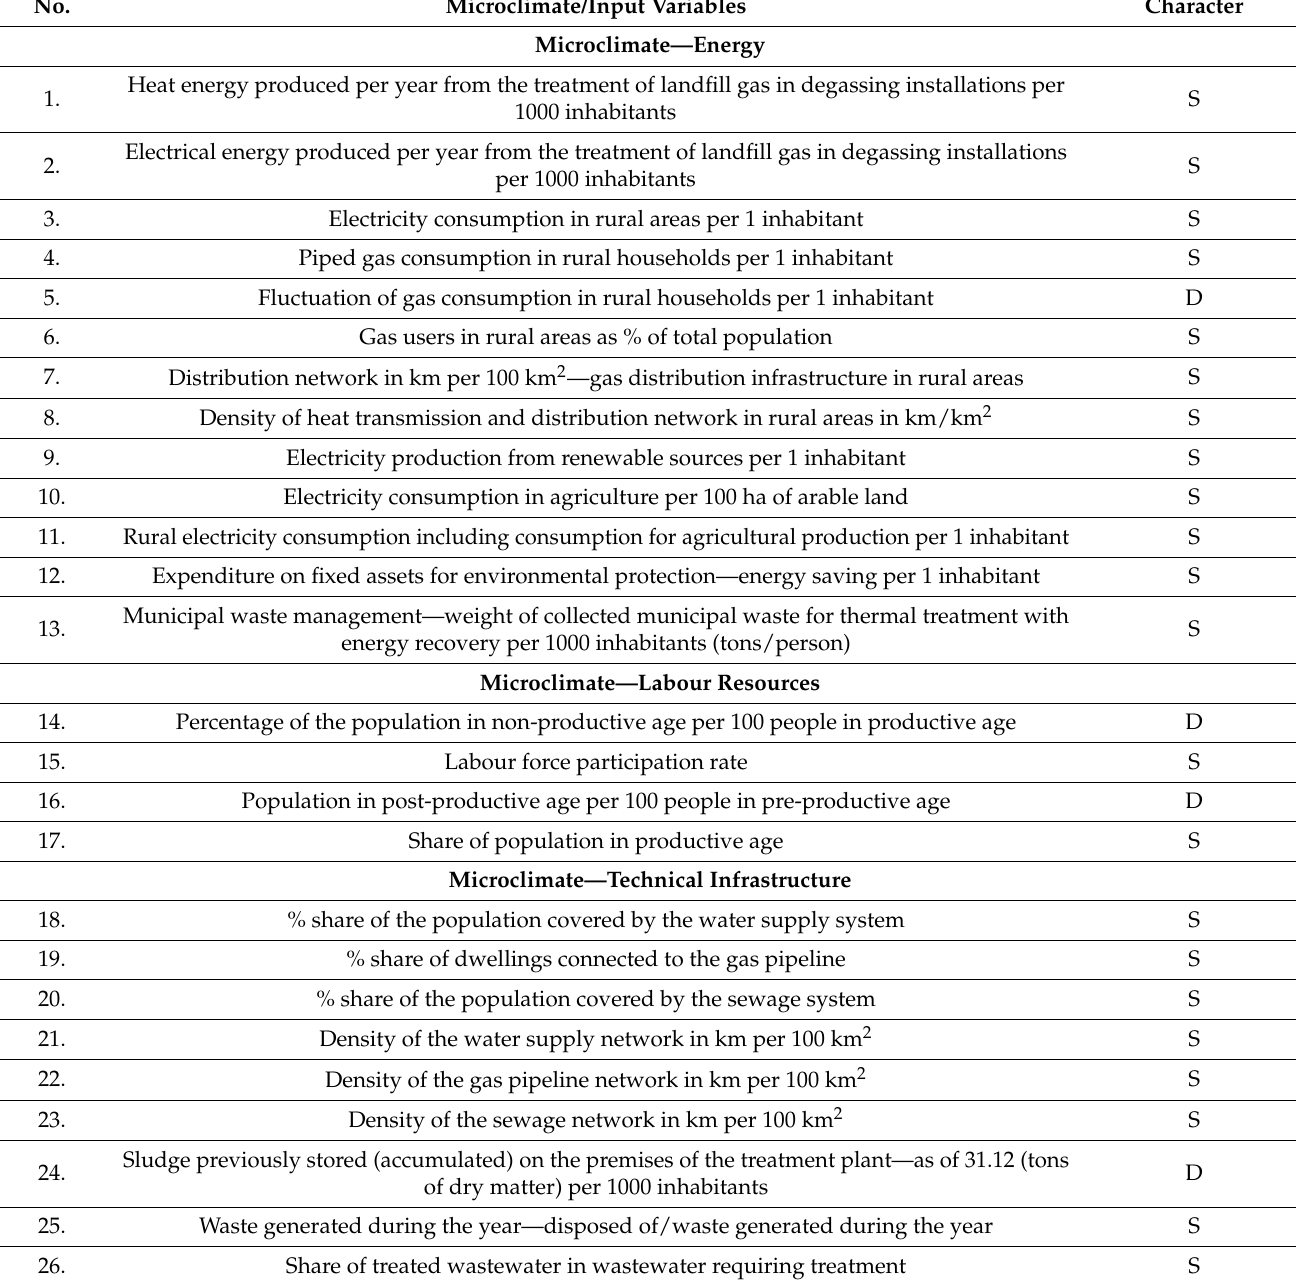
Table 1. Input variables for estimating potential investment attractiveness of Section A businesses at regional level (voivodeships) in Poland in 2019 (PAI A